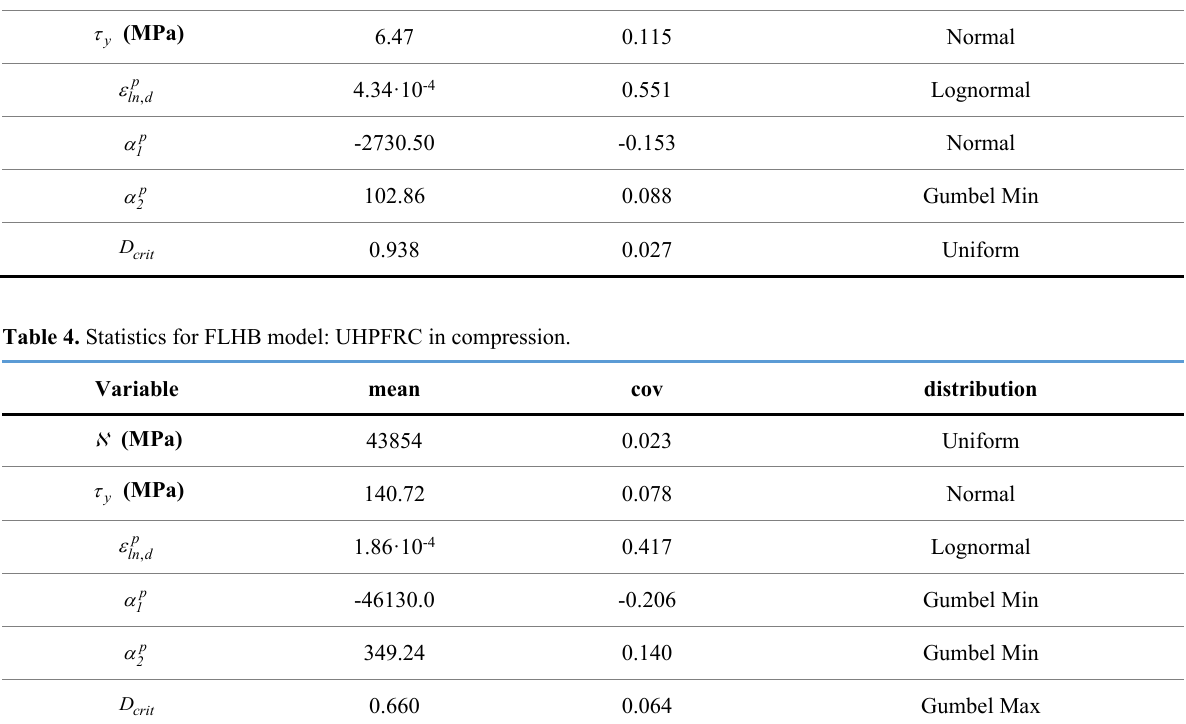
Table 3. Statistics for FLHB model: UHPFRC in tension.